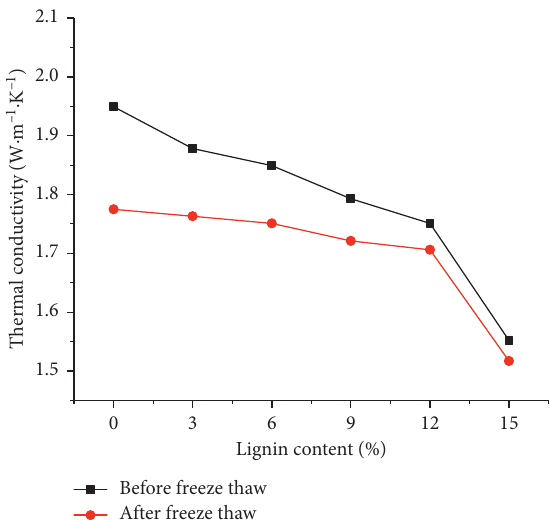
Figure 8: Effect of freeze-thaw and lignin content on the thermal conductivity.